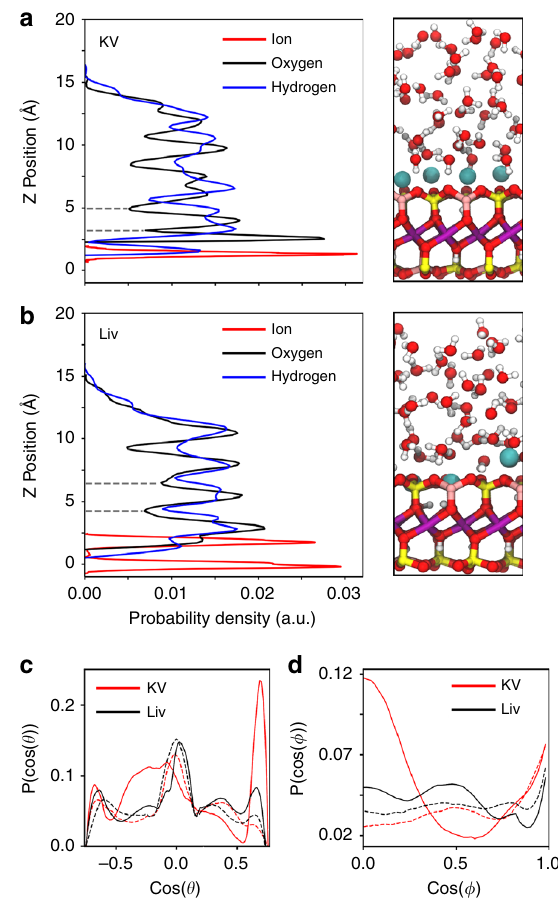
Fig. 4 Cation hydration structures on vermiculite surface. a, b Probability density plots for thin water fi lms on vermiculite surfaces substituted with potassium and lithium, respectively. The y -axis zero is taken to be the mean z position of the vermiculite surface oxygen atoms. Grey dotted lines indicate the distinction between the fi rst and second contact layers of water. Snapshots are included showing the simulated liquid fi lms and vermiculite structures on the right-hand side. Oxygen atoms are shown in red, hydrogen in white, silicon in yellow, aluminium in pink, magnesium in purple, and lithium and potassium in cyan. c Angular orientation of water molecules in the fi rst and second contact layers of water using the angle between the vermiculite surface normal and water O – H bonds ( θ ). Distributions for the fi rst contact layer are shown with solid lines, dashed lines represent the second layer of water. d Angular orientations of water molecules using the angle between the plane through the water molecule and the basal plane of the vermiculite surface ( φ ). Distributions for the fi rst contact layer are shown with solid lines, while the second contact layer is shown with dashed lines. All source data are provided as a Source Data fi fi rst and second contact layers (Fig. 4c, d). The contrast between the highly ordered KV contact layer, and the disordered LiV contact layer can be clearly seen in the plots of the probability density perpendicular to the surface (Fig. 4a, b), where the peaks in the fi rst contact layer of water (~3 Å above the vermiculite surface) in the probability density for water oxygen and hydrogen atoms are well de fi ned and sharp in the case of KV but broad and poorly de fi ned for LiV (below ~4.5 Å). Most importantly, we note that unlike the contact layer, subsequent layers of water are far